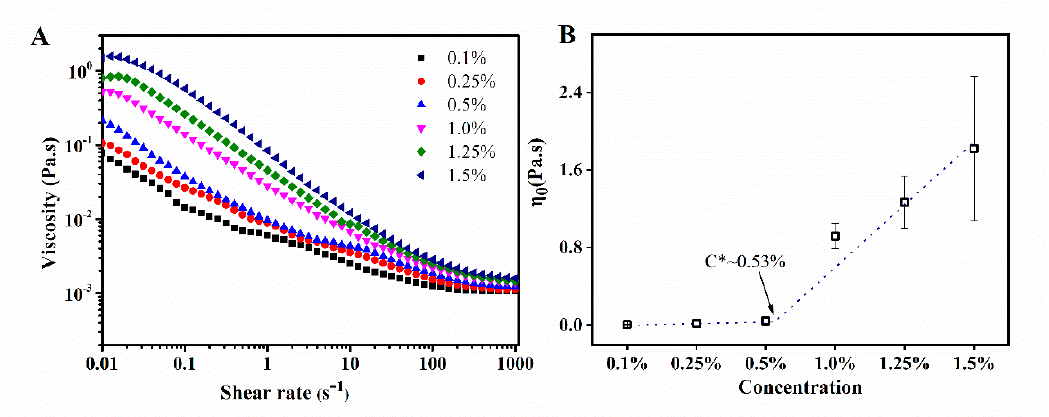
Figure 1. Rheology diagram of WPI fibrils solutions with the concentrations of 0.1 wt.%–1.25 wt.% ( A ) Steady flow curves and ( B ) the relationship between η 0 and of WPI fibrils concentrations (pH 2.0).